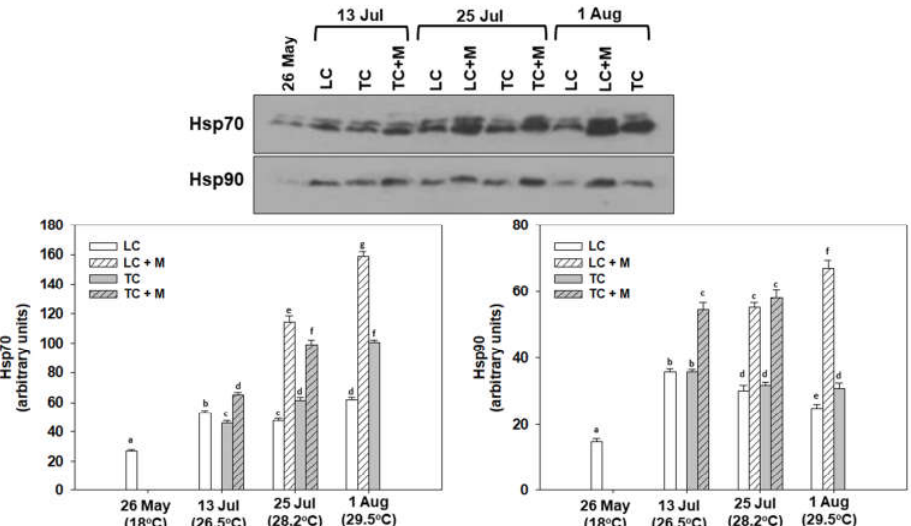
Figure 7. Hsp70 and Hsp90 levels in the mantle of M. galloprovincialis specimens, either infected by Martelia spp. (M) or not. Samples were collected from Thermaikos gulf during a summer heatwave both from traditional culture-Bouchot (TC) and long-line system (LC). Representative blots are shown. Values represent means ± SD; n = 5 preparations from different animals. Lower case letters indicate statistically significant differences ( p < 0.05) between samples. Original blots: Figure S1.